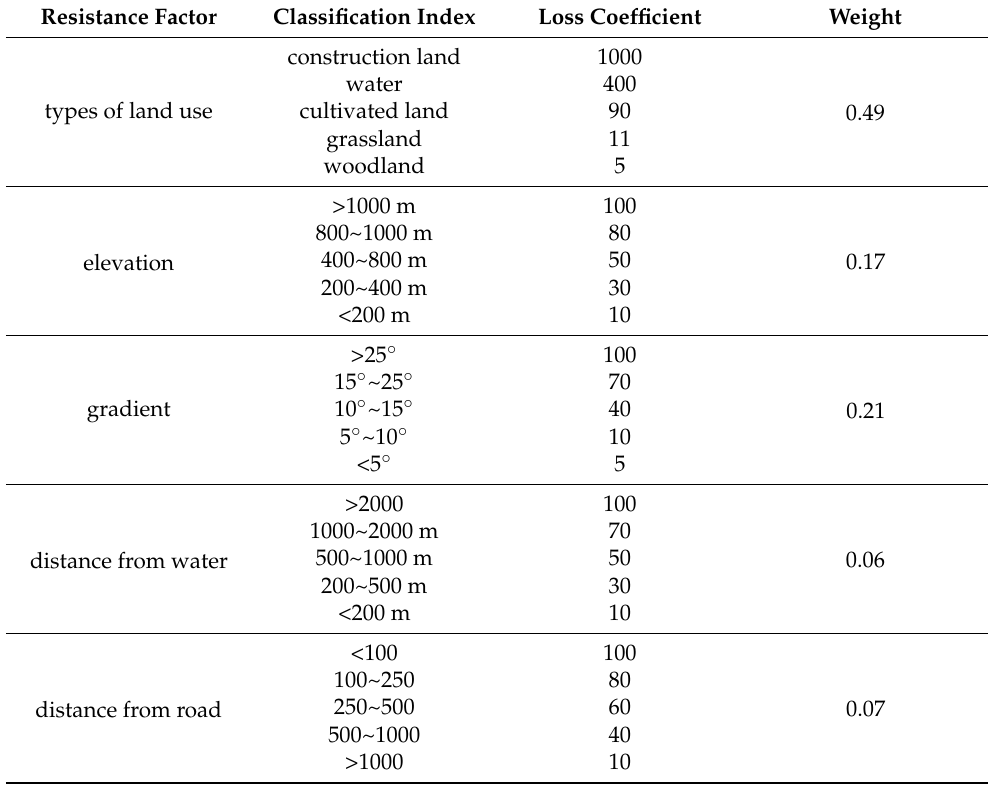
Table 5. Ecological resistance factor grading assignment and weight. Resistance